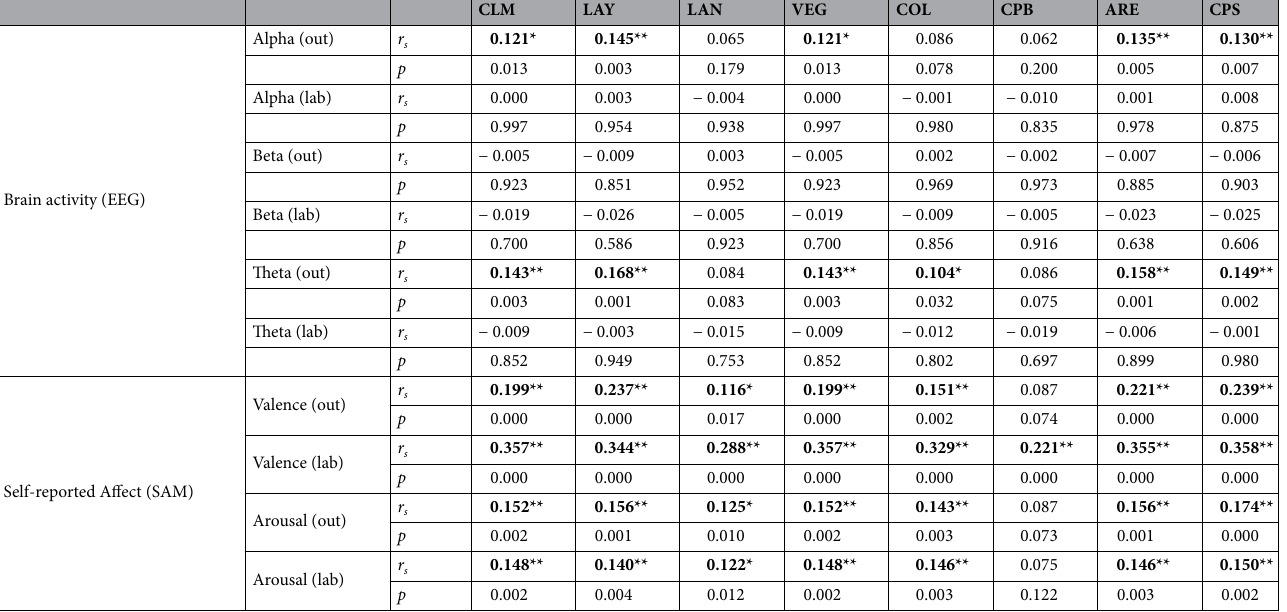
Table 2. Results of Spearman rank-order correlation. Significant values are in [bold]. LAY, layers of the landscape; LAN, landform; VEG, vegetation; COL, color and light; CPB, compatibility; ARE, Archetypal